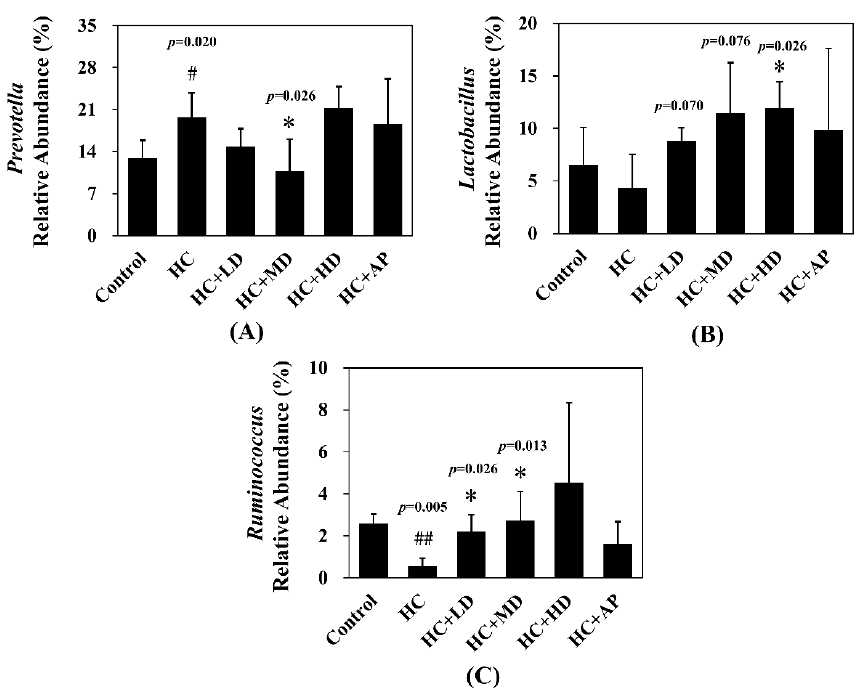
Figure 8. Effect of TCI227 on relative abundances of Prevotella ( A ), Lactobacillus ( B ), and Ruminococcus ( C ) in feces. The reported values are means ± SD (n = 3); # significantly differs from the HC group ( p < 0.05); ## significantly differs from the HC group ( p < 0.01); * significantly differs from the HC group ( p < 0.05).